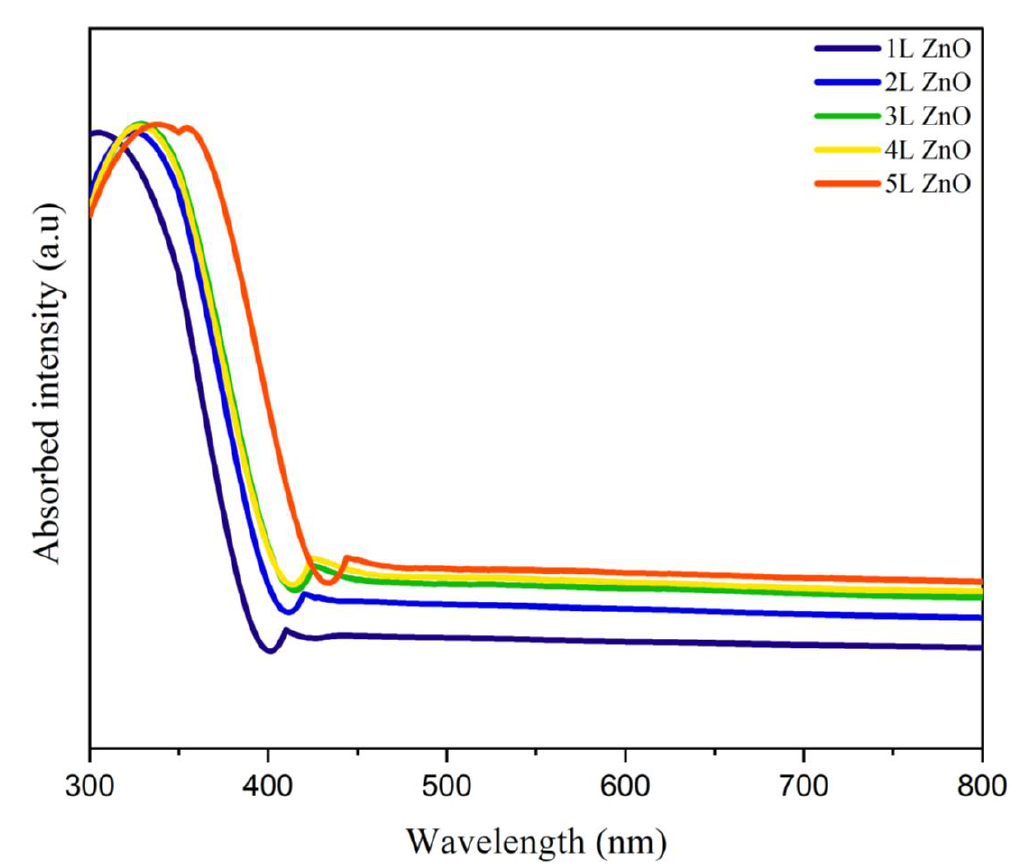
Figure 6. The absorbance of the ZnO photoanode without dye.